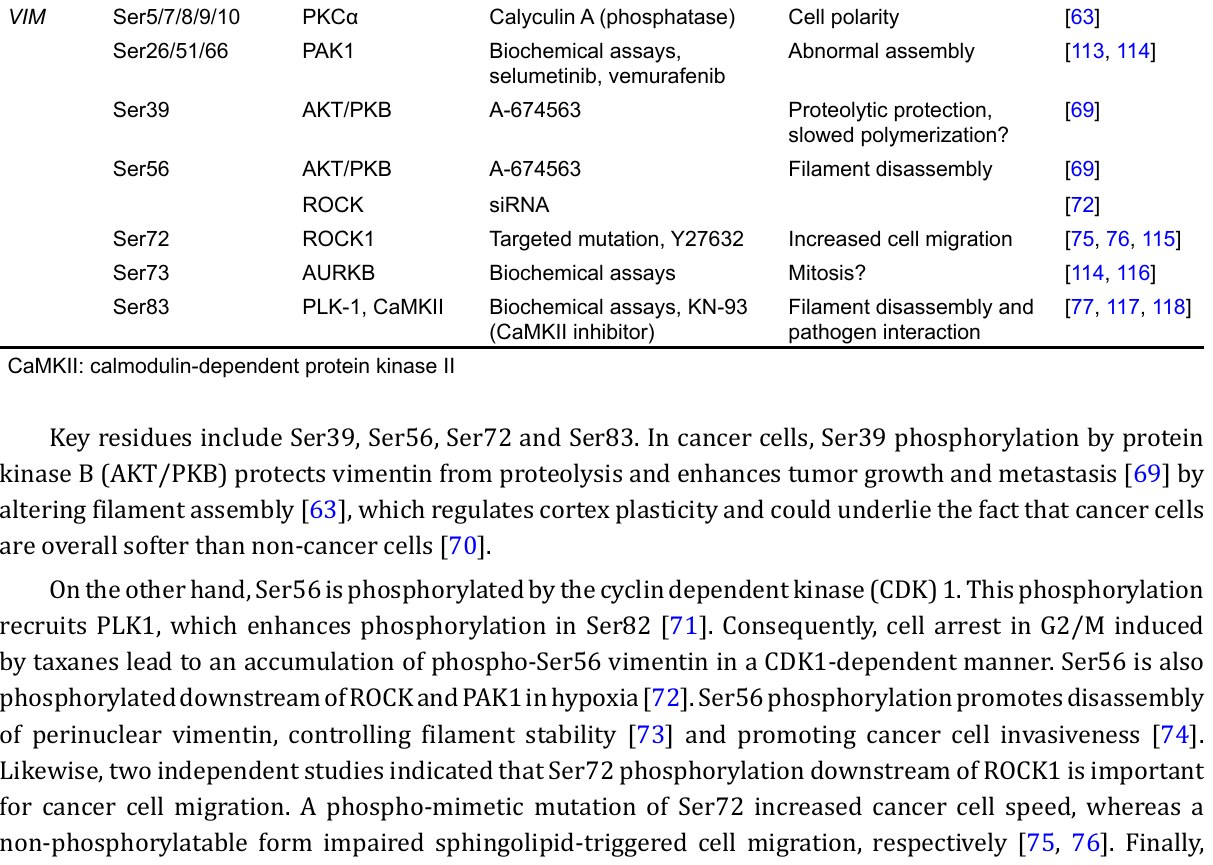
Table 4. Main human vimentin phosphorylation sites Gene